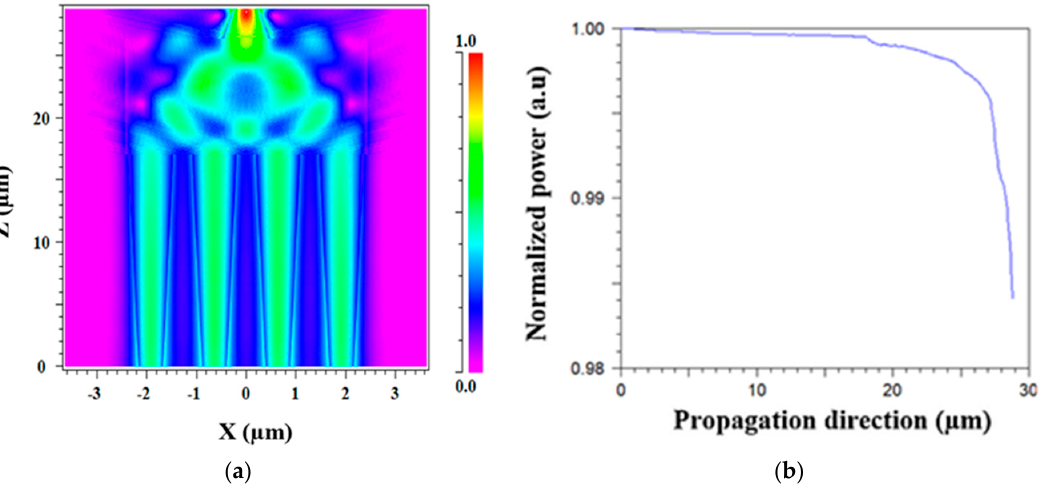
Figure 7. Intensity light propagation profile for the 4 × 1 MMI power combiner: ( a ) plane x-z under TE mode; ( b ) z-axis under TE mode.